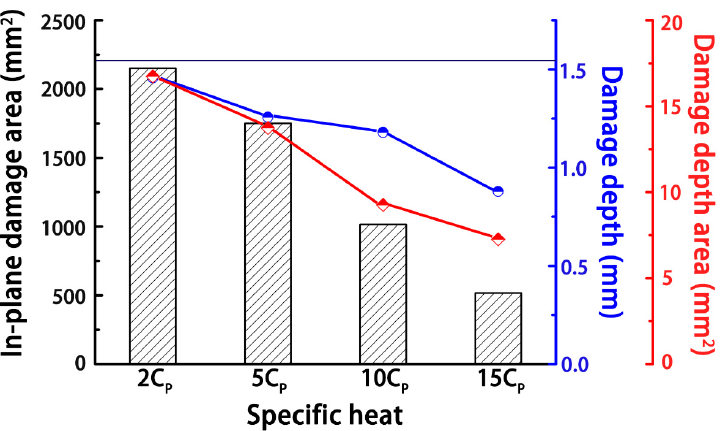
Figure 16. Influence of the specific heat capacity on the degree of lightning damage to the composites. The number in front of the specific heat capacity (C p ) indicates the number of the increment, and the black line represents the degree of damage in the original composite.